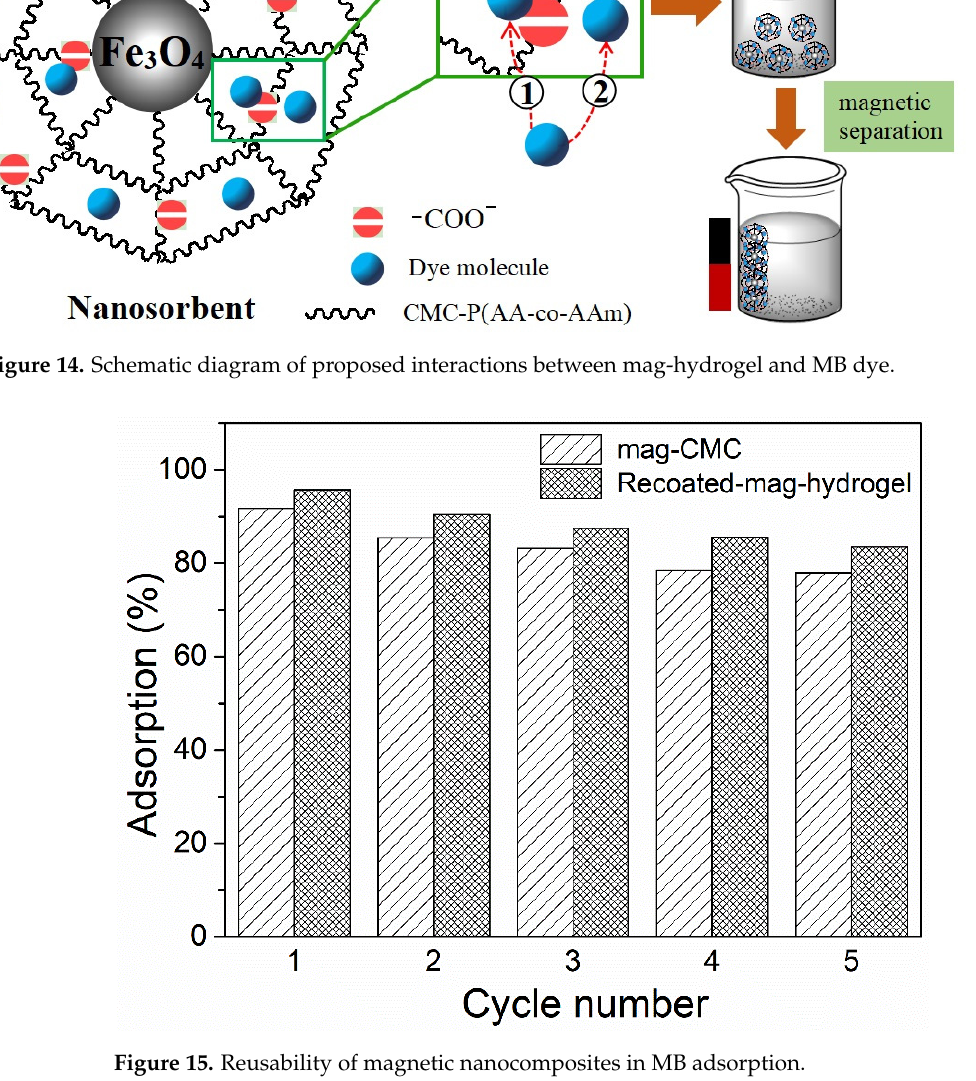
Figure 15. Reusability of magnetic nanocomposites in MB adsorption.